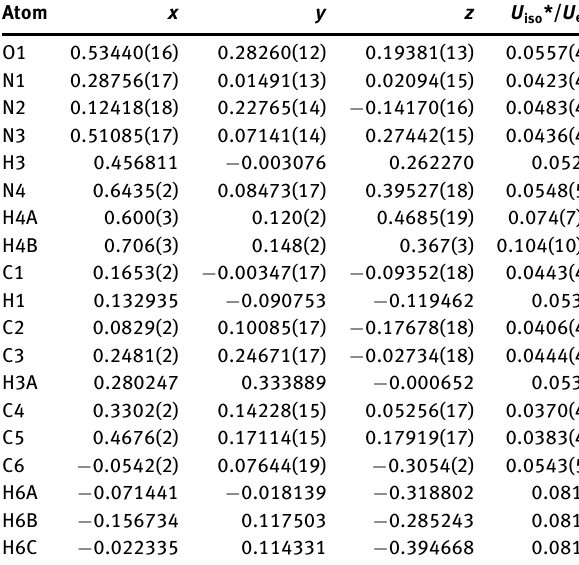
Table 2: Fractional atomic coordinates and isotropic or equivalent isotropic displacement parameters (Å 2